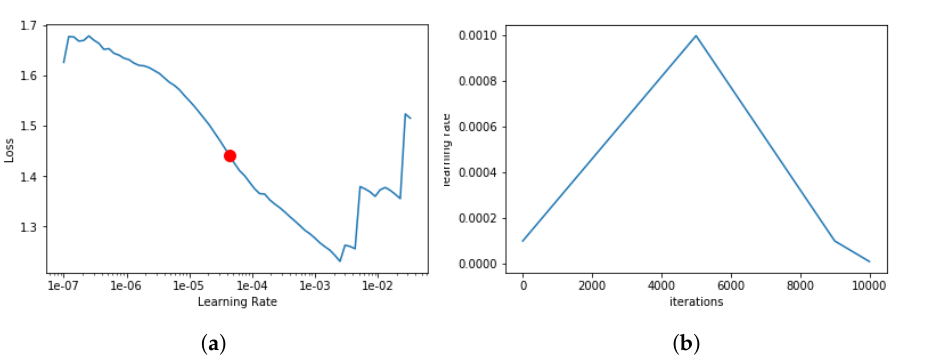
Figure 10. Learning Rate (LR) tuning analysis for the ReFuse model. ( a ) The output of the LR range test. The figure highlights the maximum learning rate before loss increases. ( b ) Learning rate values during training with the one-cycle policy [39]. The one-cycle strategy increases the learning rate from an initial value to a maximum learning rate. It then decreases the learning rate from the maximum value to some minimum, which is substantially lower than the starting learning